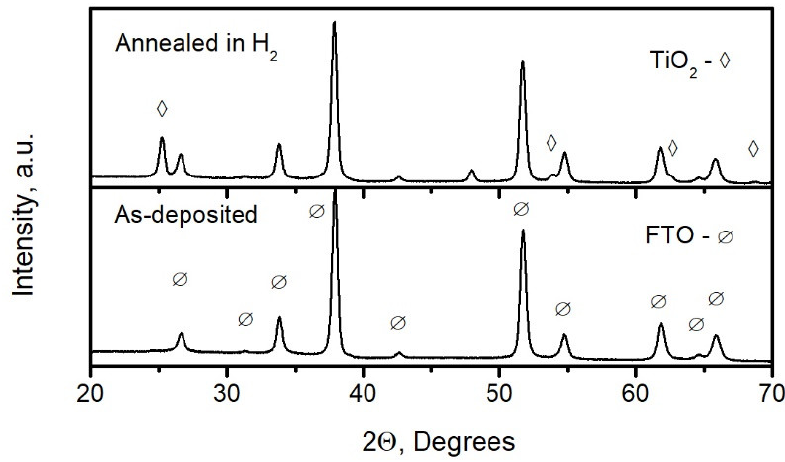
Figure 3. XRD patterns of the Ti 0.93 Nb 0.07 O 2 film before (as-deposited) and after annealing in a H 2 atmosphere.